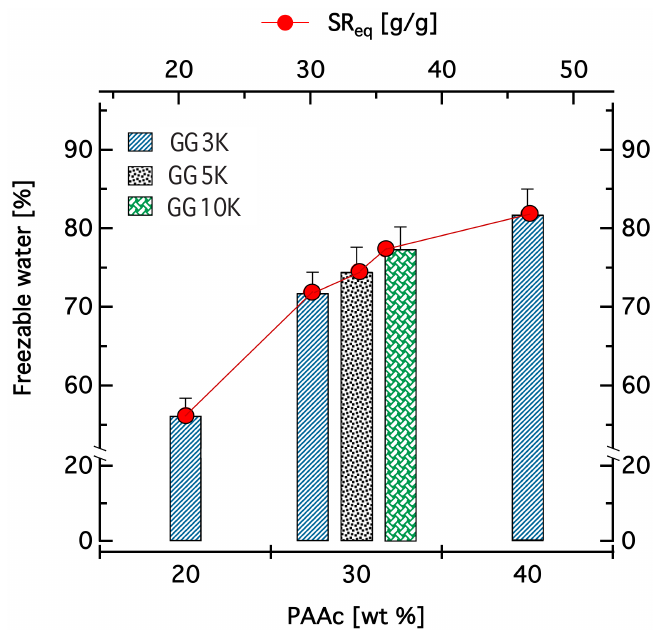
Figure 9. Freezable water content estimated from the DSC thermograms for the studied hydrogels as a function of grafted PAAc content ( bars mode ) and swelling ratio at equilibrium ( markers mode